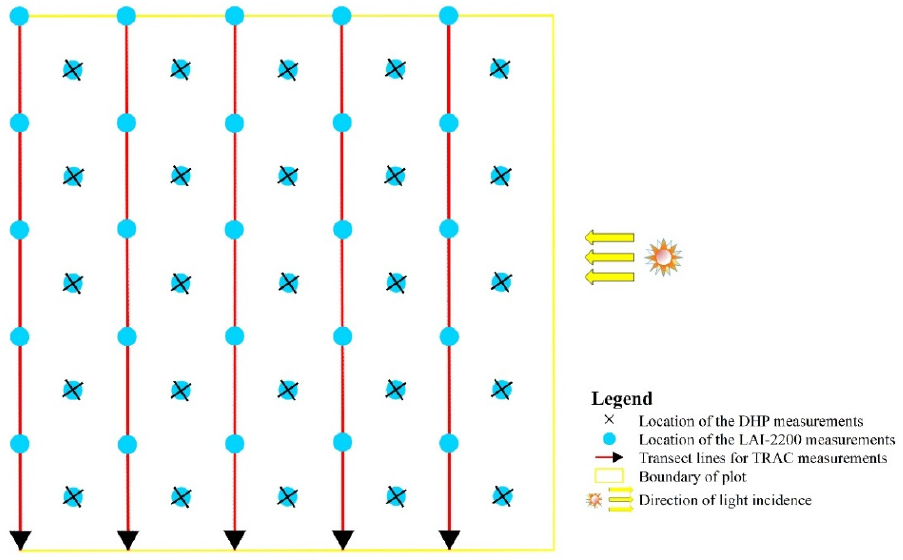
Figure 3. Spatial distribution of measuring points of LAI-2200 and DHP and the TRAC transect line. The DHP images were taken with a fixed azimuth angle using Nikon D800 (Nikon, Tokyo, Japan) with a 4.5 mm F2.8 EX DC circular fisheye converter. The position of the